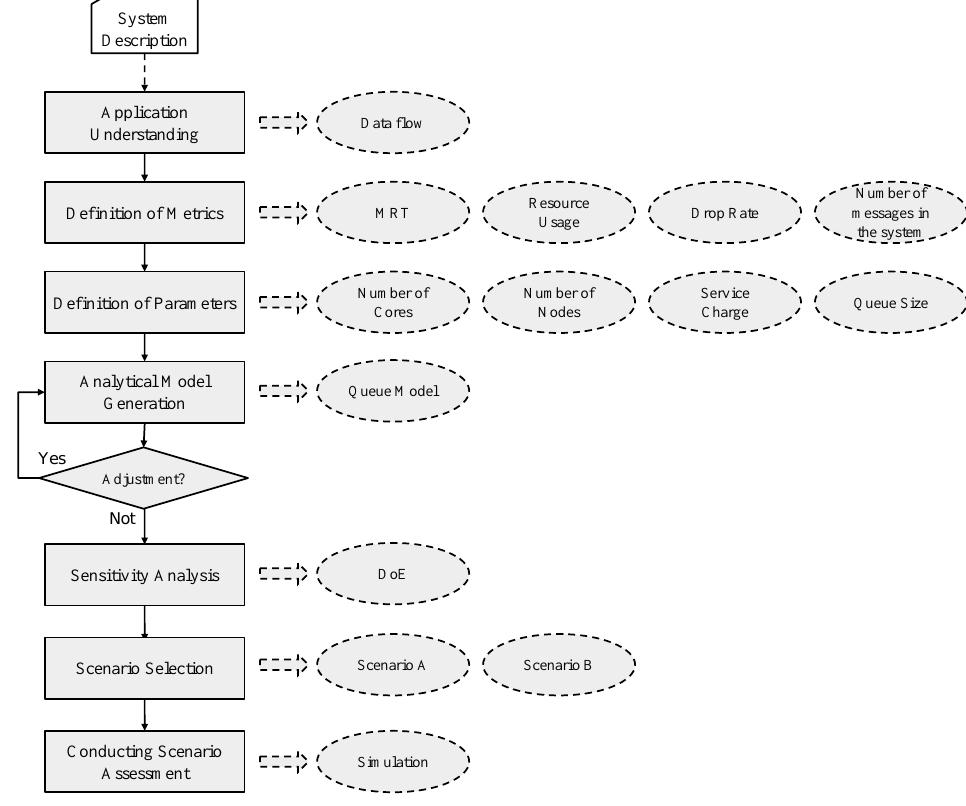
Figure 1. Analytical model development